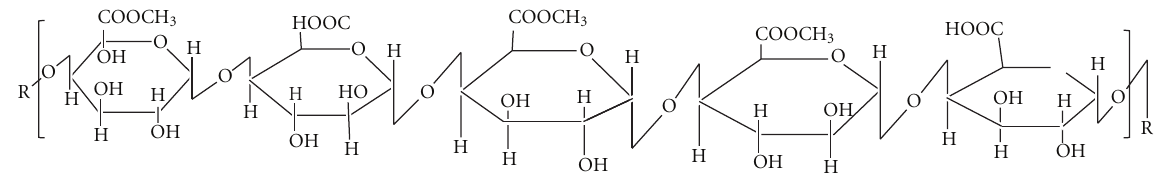
Figure 1: Structure of pectin.